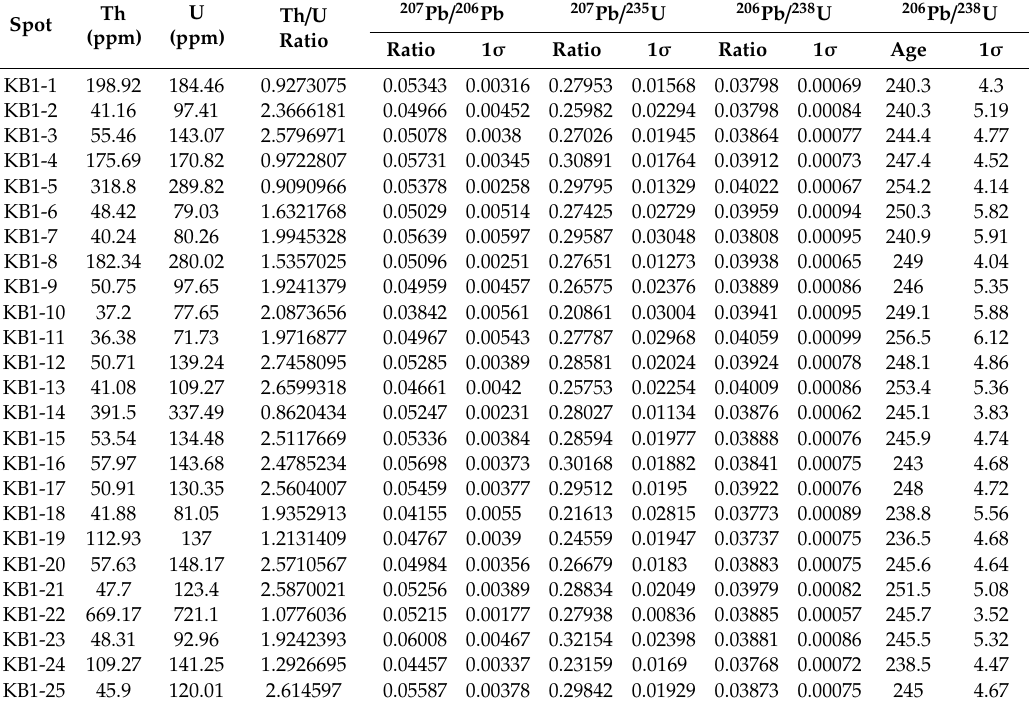
Figure 3. ( a ) Cathodoluminescence (CL) images of the selected zircons for LA–ICP–MS dating; ( b ) Concordia diagram of zircon U–Pb age for the Qilinshan basalts. Table 1. U–Pb isotopic compositions for zircon from Qilinshan basalts sample